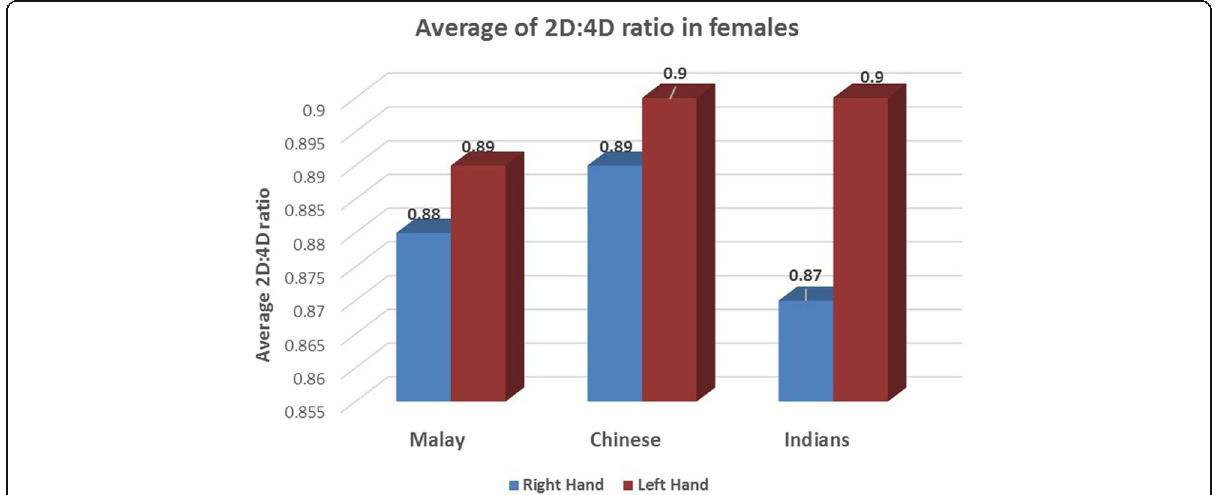
Fig. 7 Graph showing the average of 2D:4D ratio in females segregated according to